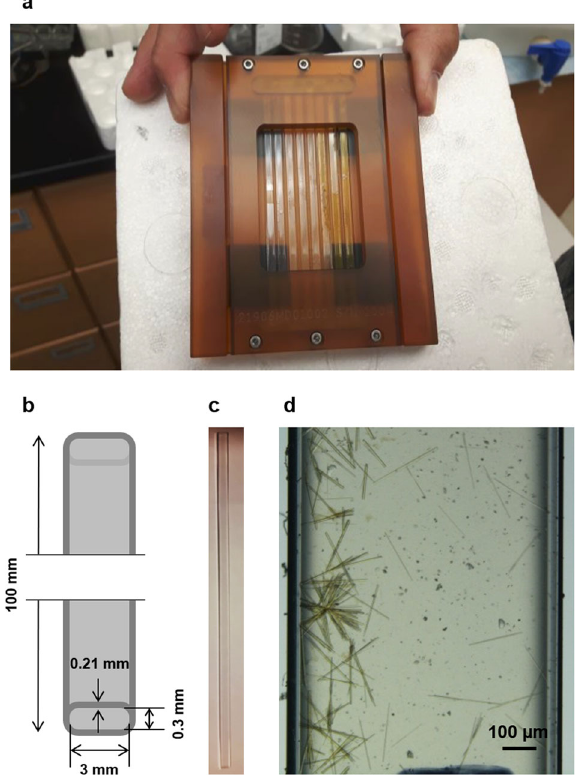
Fig. 3 Crystallization experiment hardware. a The SPX11 fl ight cassette contained eight capillaries: capillaries 1 – 3 contain lysozyme, capillaries 4 and 5 contain bovine serum albumin and capillaries 6 – 8 contain Pf GST. b Schematic diagram illustrating the capillary